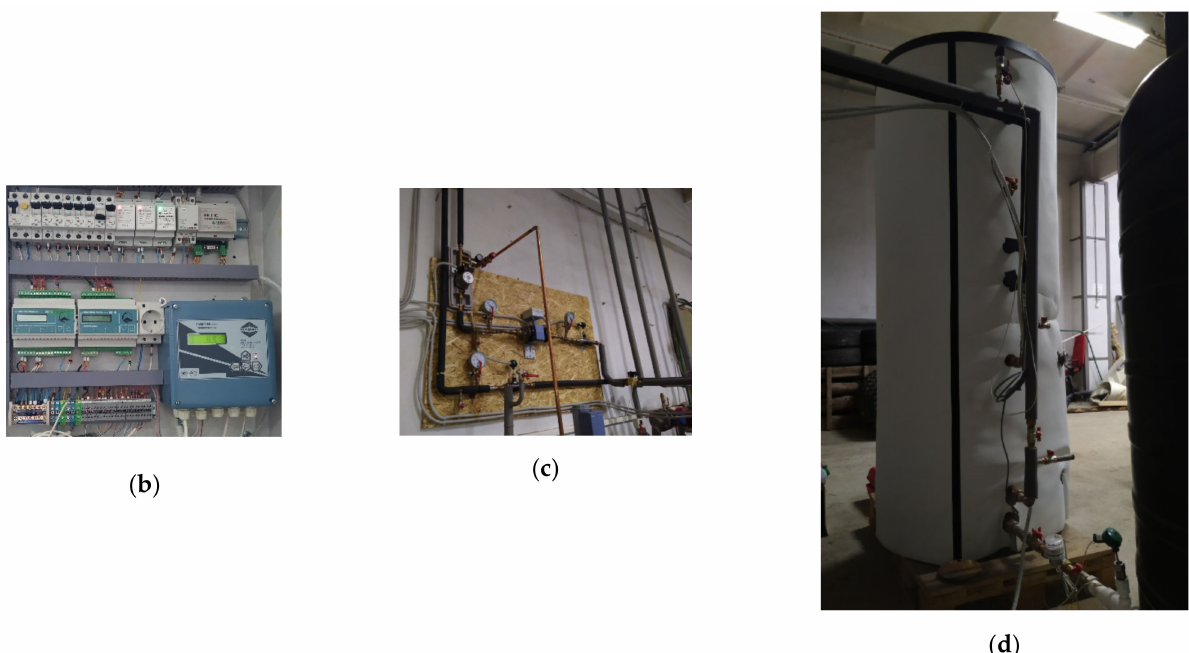
Figure 4. Photos of the solar hot water system: ( a ) two-tube collectors, ( b ) control panel with the data collection and processing unit, ( c ) steel pipe inside the house, ( d ) hot water storage